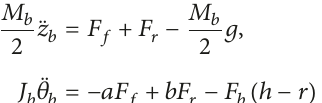
where 𝑇 𝑡𝑓 is the driving torque generated from the ground and defined as